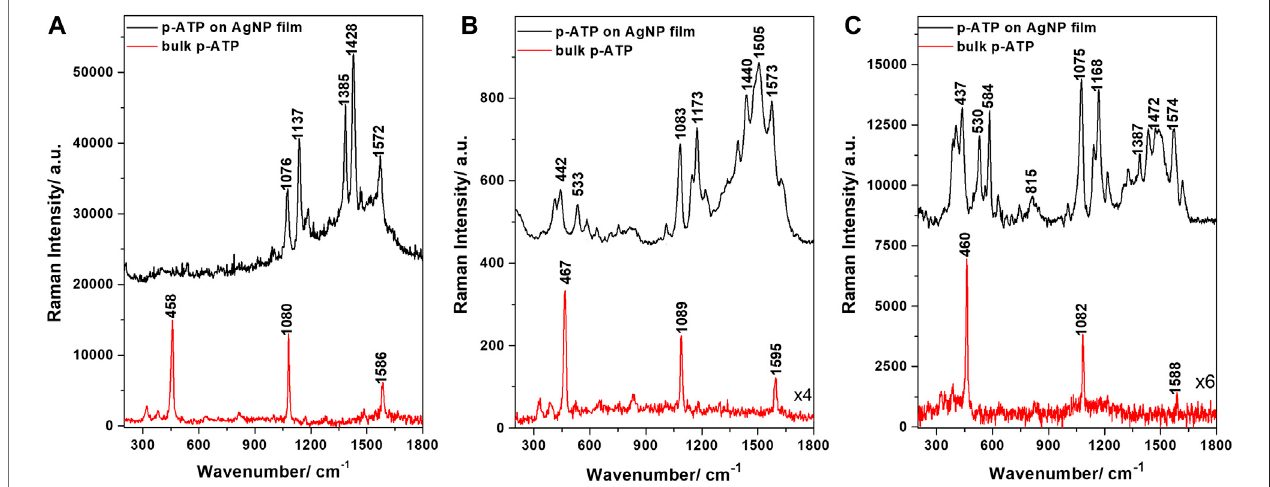
Frontiers in Chemistry |